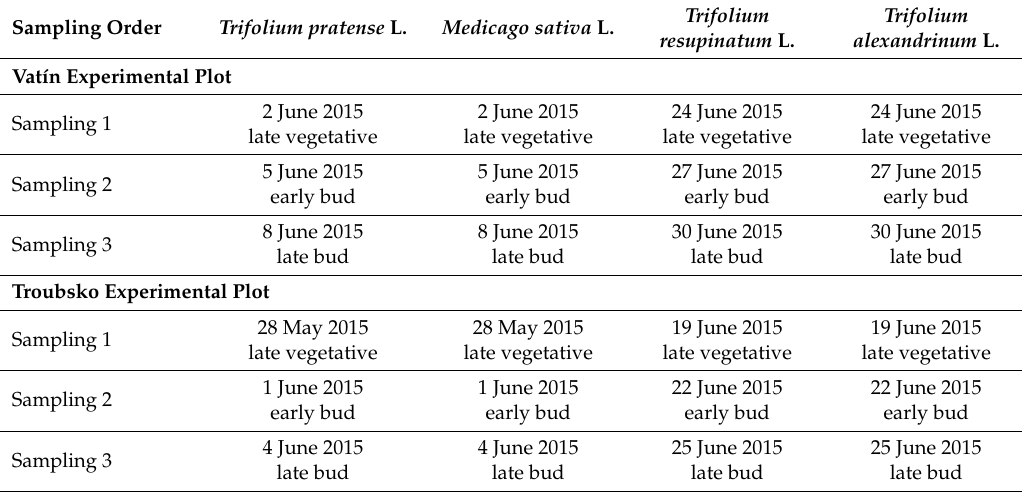
Table 1. Sampling terms and phenophase for individual species.